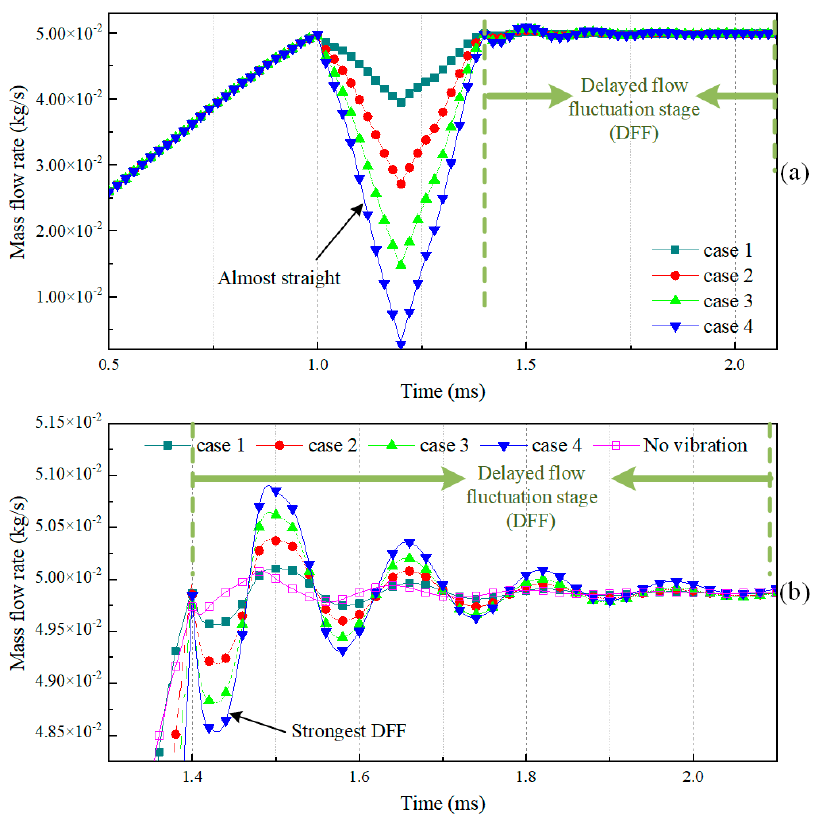
Figure 7. Effect of valve lift-vibration amplitude on the mass flow rate of the NG injector (( b ) is the partial enlargement of ( a )).